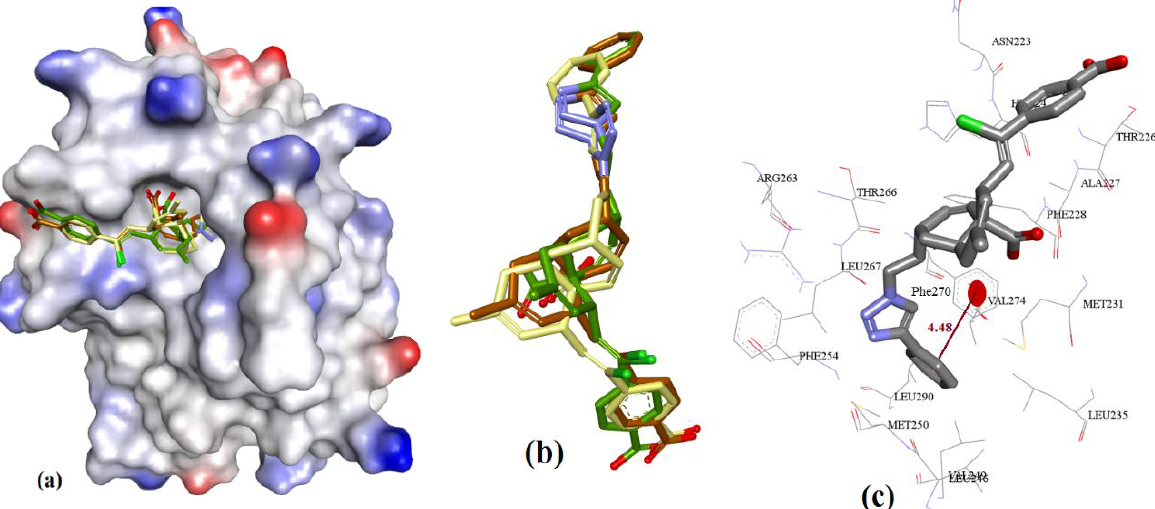
Figure 23. ( a ) The ionized solvent-exposed surface mapping of hMcl-1 along with the docked poses of 8b from MOE (in brown), AutoDock (in green), and VlifeDock (in yellow) show their fitting to the cavity. ( b ) Similar-pose ensemble clustering of all three poses was attained from the three different docking methods. ( c ) Binding mode of 8b .